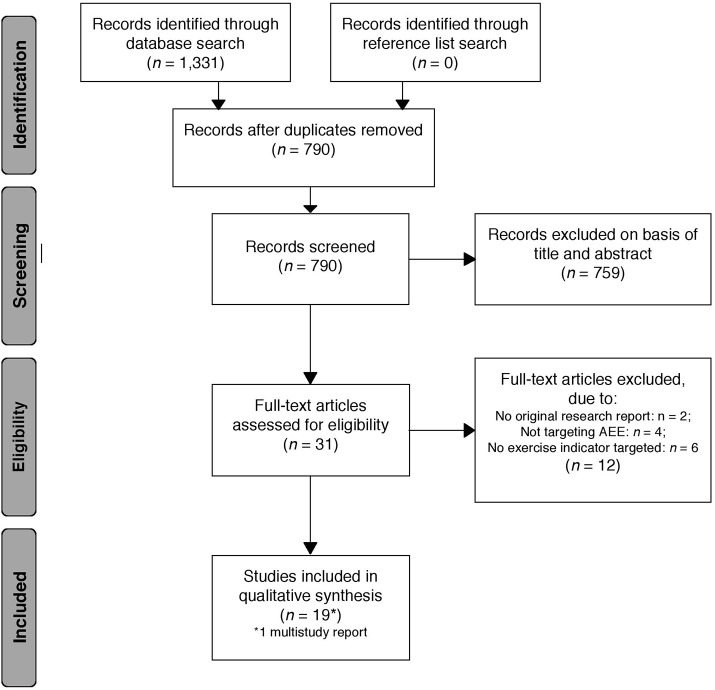
Study selection flow chart according to PRISMA statement (Moher et al., 2009).